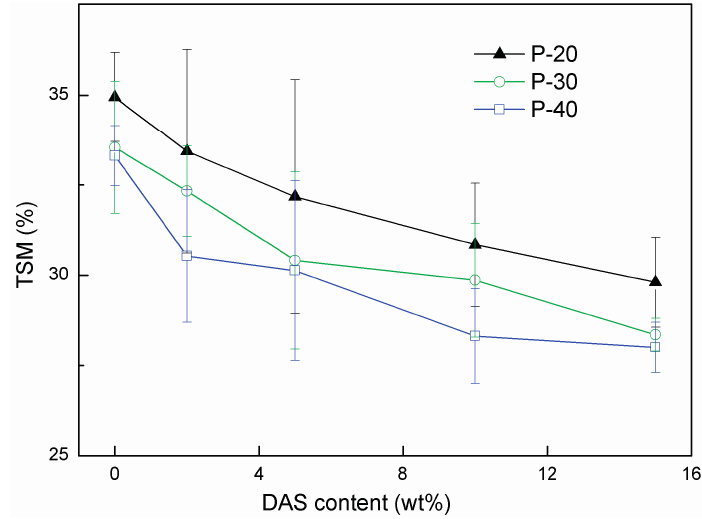
Figure 4. The total soluble mass observed for the FK/PVA blended films in deionized water at 37 °C for 24 h, plotted as a function of the DAS